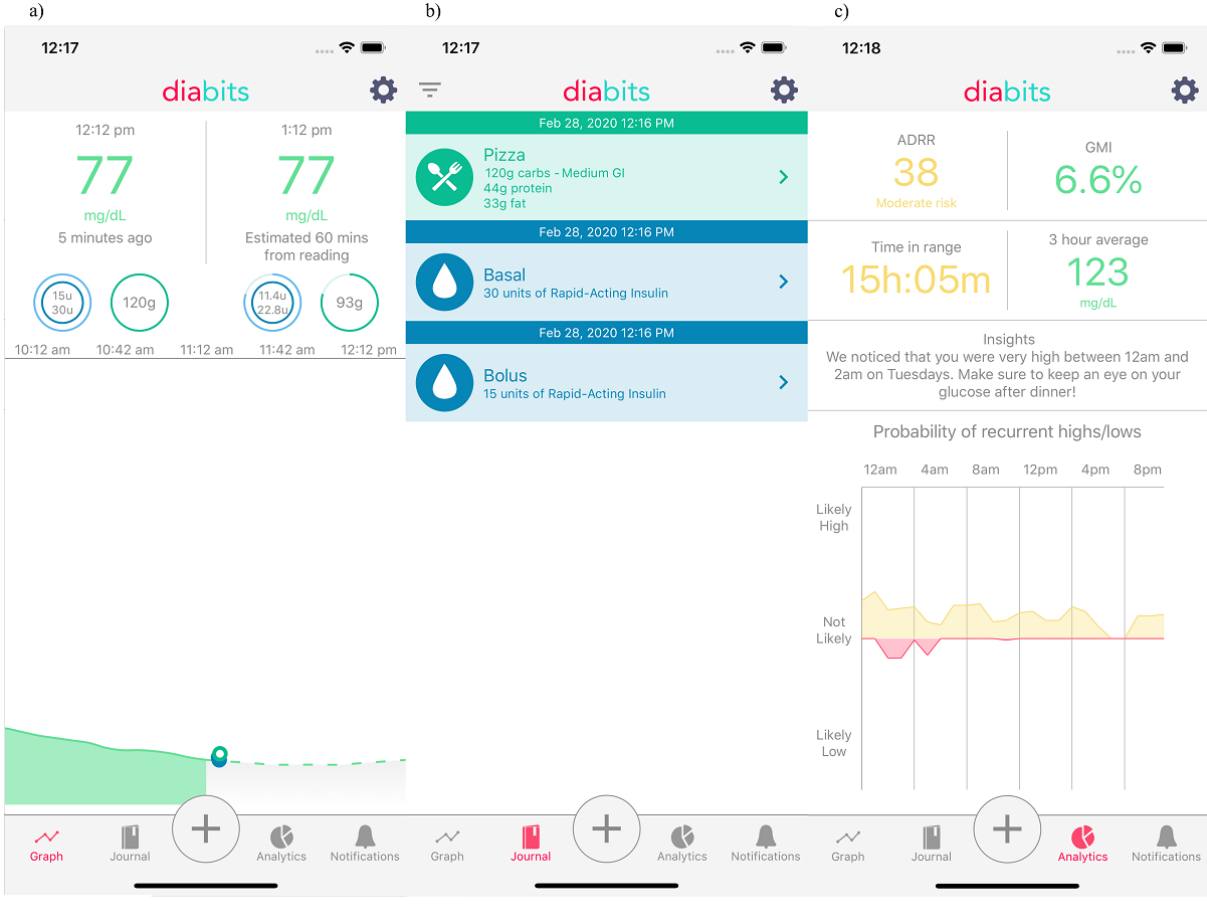
Figure 1. The interface of Diabits, including (a) the Graph panel, showing recent CGM values and the predictions for the next hour; (b) the Journal panel, where the users can enter relevant event information (food, insulin, etc), and see the past history of CGM data and events; (c) the Analytics panel, showing various glycemic statistics and insights that may help the users control their blood glucose levels. CGM: continuous glucose